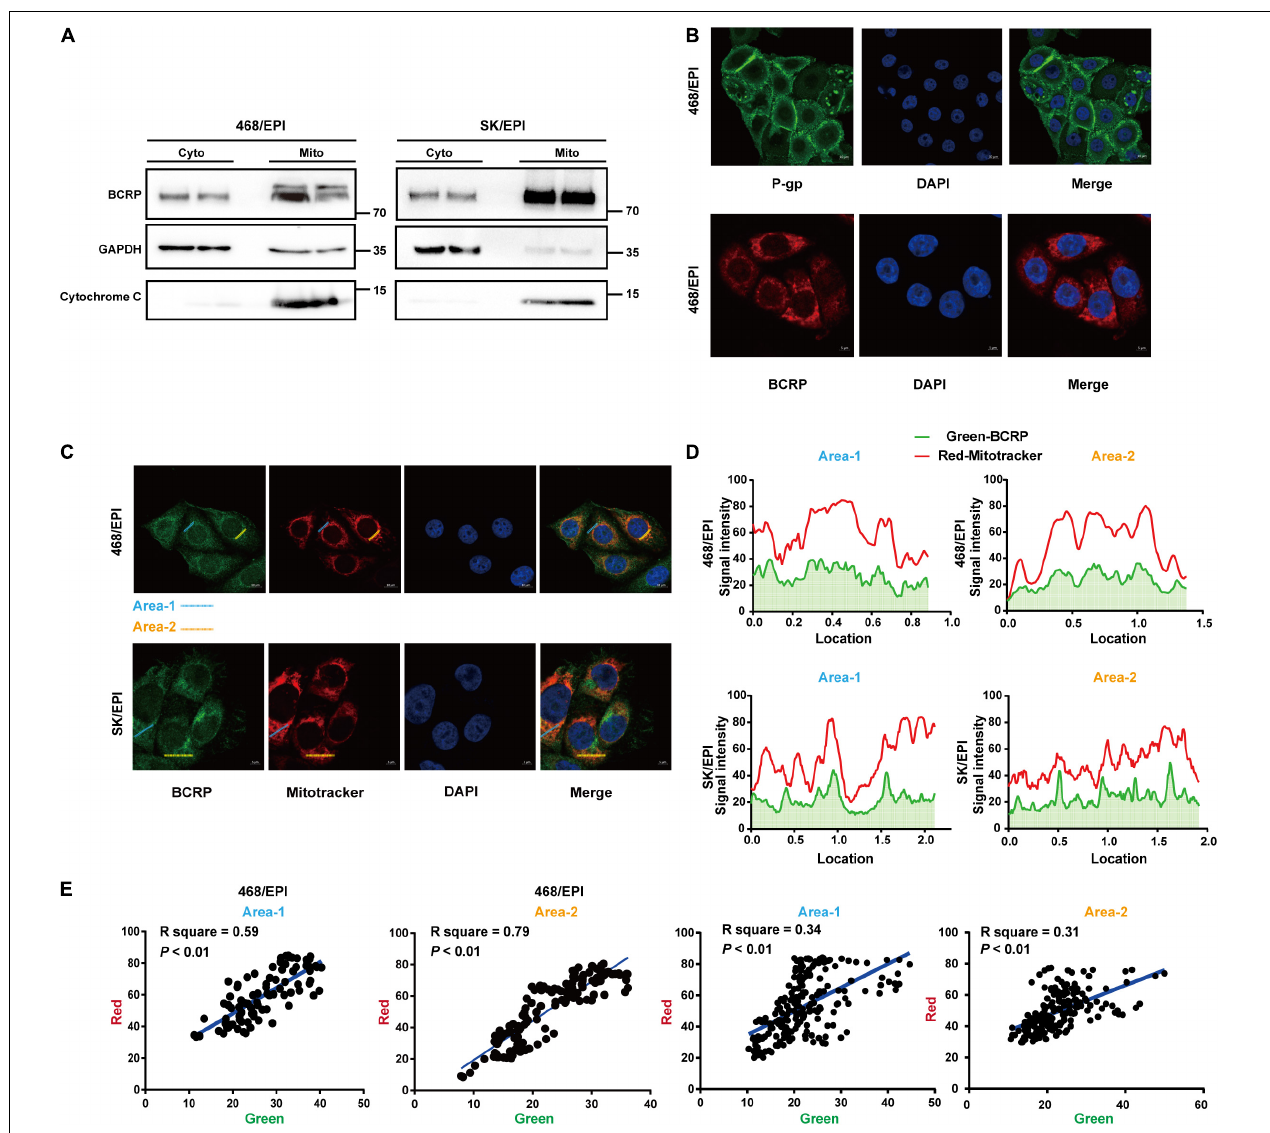
FIGURE 5 | BCRP is localized in the mitochondria of drug-resistant breast cancer cells. (A) Western blot analysis shows BCRP was expressed in the mitochondria of drug-resistant cells. The mitochondrial and cytoplasmic proteins were isolated and analyzed using a Mitochondrial Extraction Kit; GAPDH and Cytochrome C served as markers for cytoplasm and mitochondria, respectively. (B) IF shows the subcellular localization of P-gp and BCRP in 468/EPI cells. (C) IF shows that BCRP was localized in the mitochondria of drug-resistant cells. (D) Analysis of the fluorescent signal intensity of the area indicated in the IF image. (E) Correlation analysis of the signal intensity of BCRP (green) and mitochondrial (red) through linearized regression. The signal intensity for each fluorescent channel was analyzed by ImageJ, and the linear correlation coefficients were